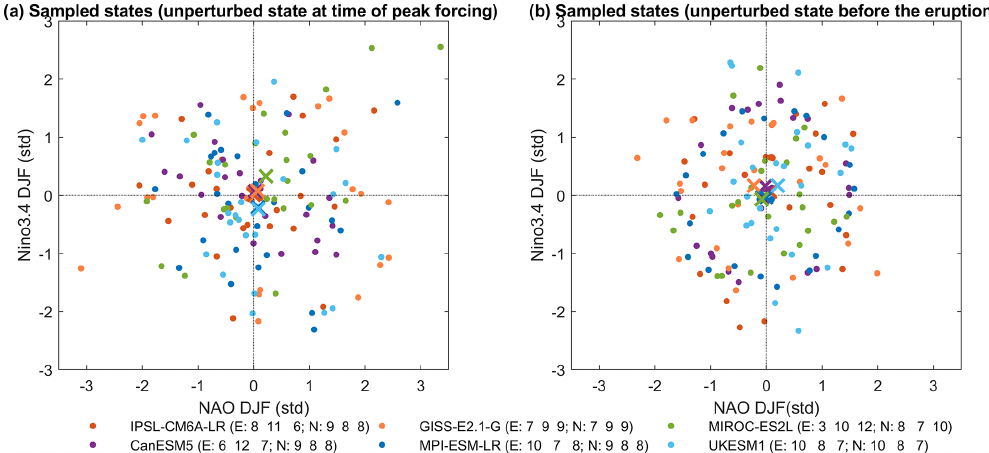
Figure 2. Scatterplots of the sampled states of winter NAO and Niño3.4 indices across the participating models. According to the VolMIP protocol, the sampled states in the piControl correspond to the first post-eruption winter in the volc-pinatubo-full simulations (DJF 1992) when there is a peak in the prescribed forcing dataset (a) . Panel (b) shows sampled states during the winter preceding the eruption (DJF 1991). Each coloured dot corresponds to 1 out of the 25 realizations for each model; crosses correspond to ensemble means. The legend at the bottom shows the colour corresponding to each model and the number of realizations pertaining to the three ranges (negative/cold; neutral; positive/warm) of each variability mode (E: ENSO; N: NAO). For both variability modes, the values shown are from indices obtained by standardization of the original December–January–February average time series over the whole piControl